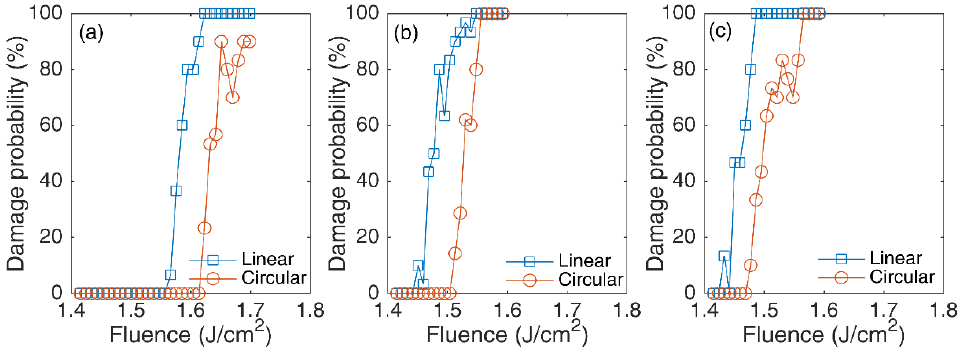
Figure 5. Damage probability of linearly and circularly polarized lasers under 2-on-1 ( a ), 5-on-1 ( b ), and 10-on-1 ( c ).